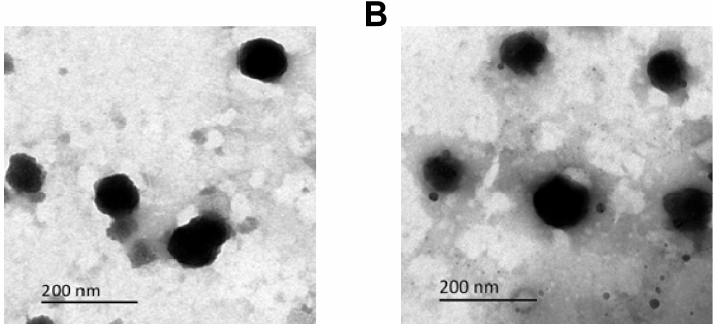
Figure 2. Transmission electron microscopy images of ( A ) SSL-GEM and ( B ) ES-SSL-GEM. Scale bar: 200 nm.